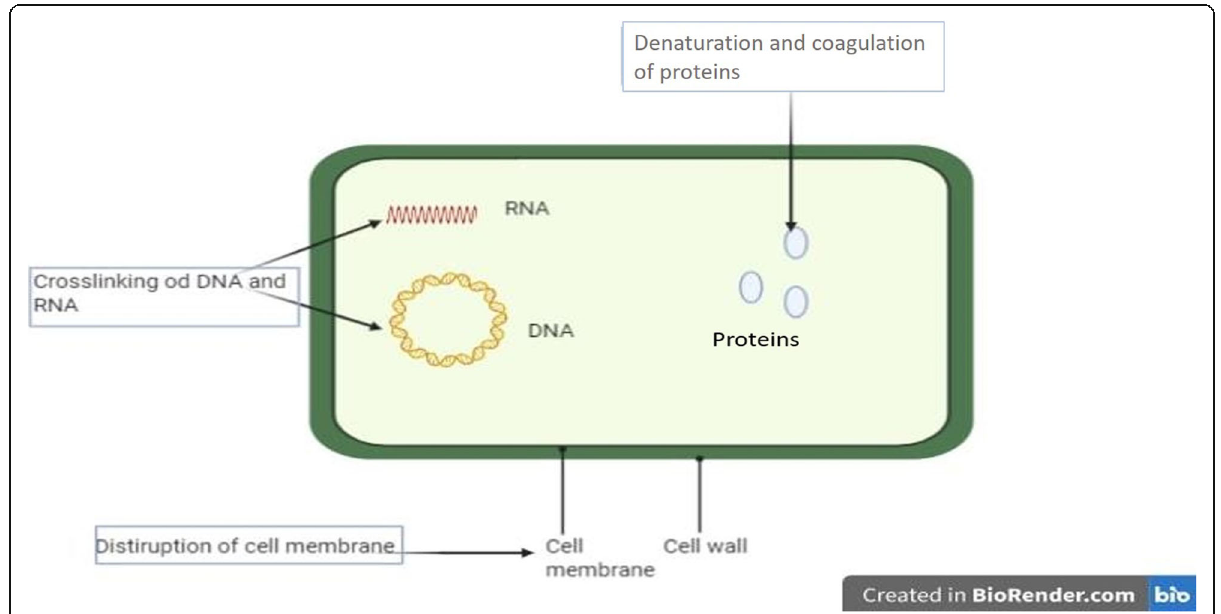
Fig. 1 The main targets of the commonly used